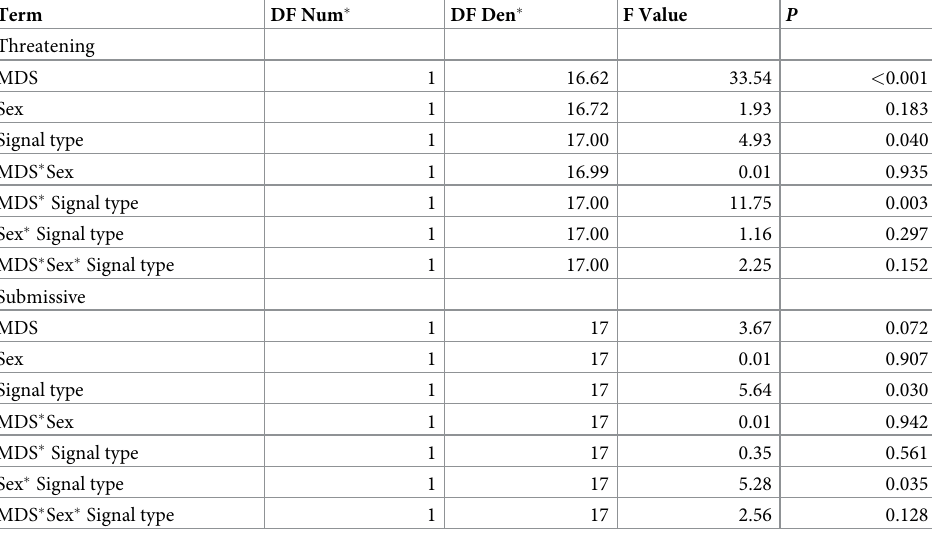
Table 5. Effect of the sender’s social rank (modified dominance David’s scores–MDS), sex, and signal type (unim- odal and multimodal signal) in the occurrences of non-aggressive responses to threatening and submissive behav- iors by white-lipped peccaries (N = 21).